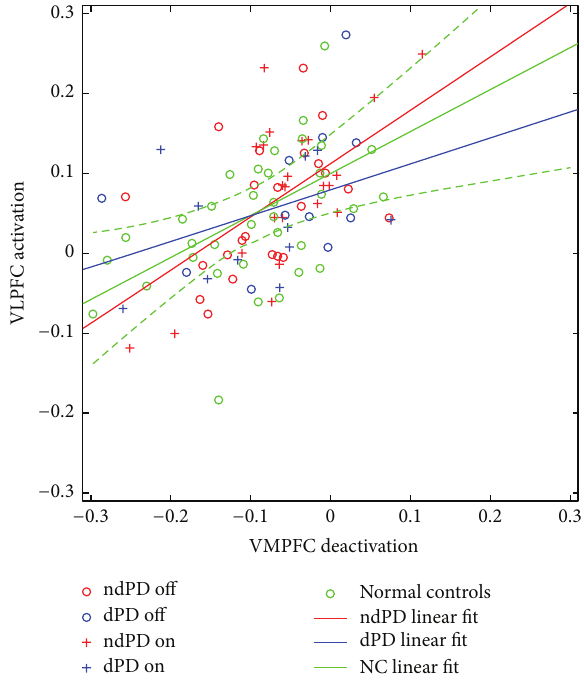
Figure 4: Scatter plots illustrating the relationship between VMPFC deactivation and VLPFC activation for the emotional face process- ing task. Observations both on and off dopaminergic medication are included. Data points for an age-matched group of normal control subjects are added for comparison. Solid lines depict fits to data from each group separately. The dashed green lines indicate the 95% confidence interval for the linear curve fitting data from a separate group of age-matched normal controls scanned under the same protocol but not part of this